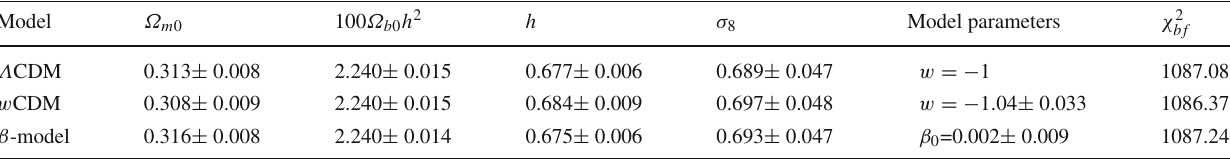
Table 2 A summary of best-fit values of the main cosmological parameters calculated by using MCMC chains. The χ 2 values from MCMC chains of each individual model.